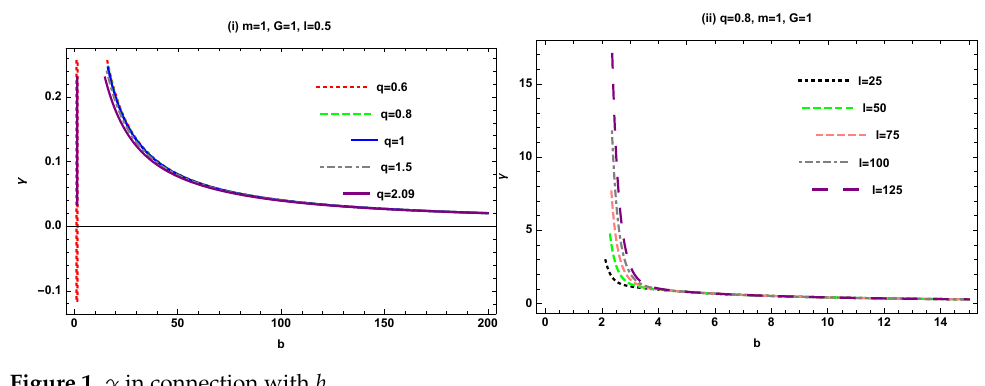
Figure 1: γ in connection with b . Figure 1. γ in connection with b .